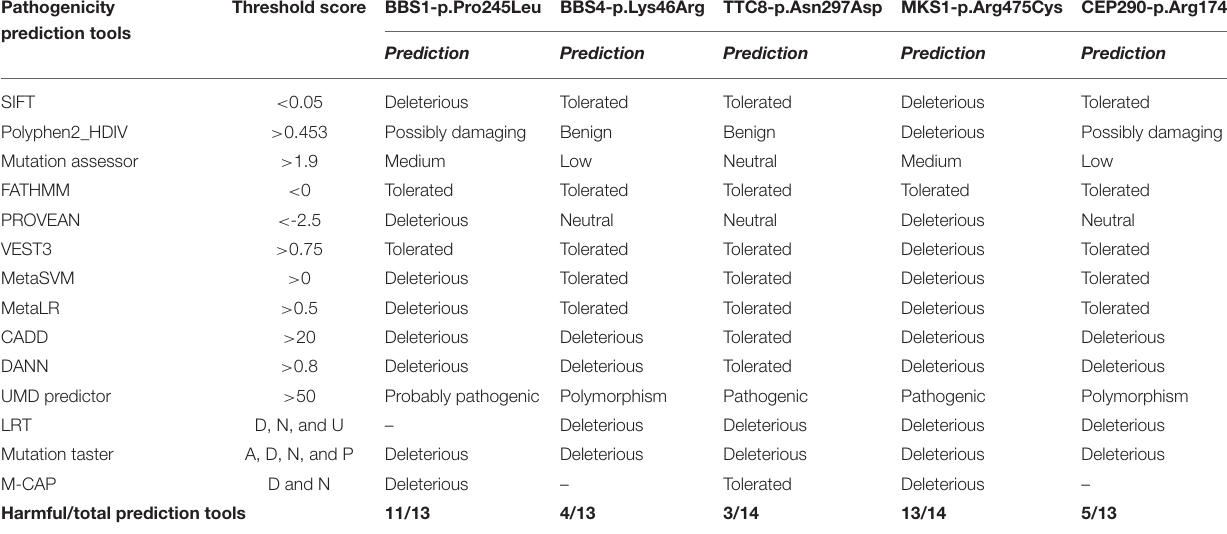
TABLE 2 | Pathogenicity prediction scores for the five genetic variants identified in the diabetic Tunisian patient. Pathogenicity prediction